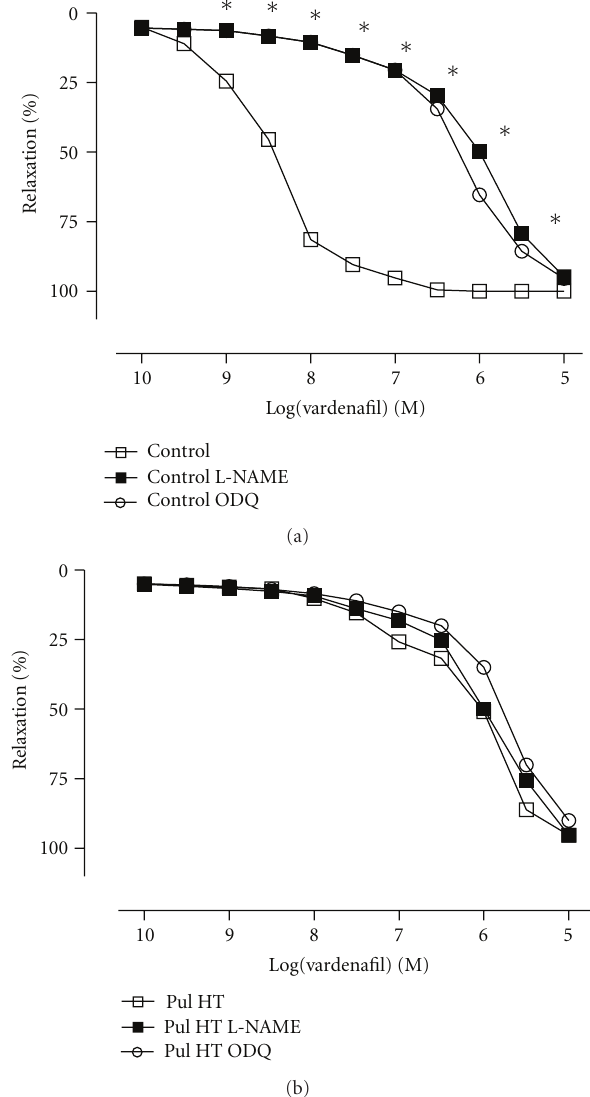
Figure 3: E ff ects of L-NAME (10 − 4 M; n = 15) and ODQ (10 − 5 M; n = 15) on the relaxations induced by vardenafil in control (a) and pulmonary hypertension group (b). Data were calculated relative to the maximal changes from the contraction produced by phenylephrine (10 − 6 M) in each ring, which was taken as 100%. ∗ P < 0 . 05 as compared with